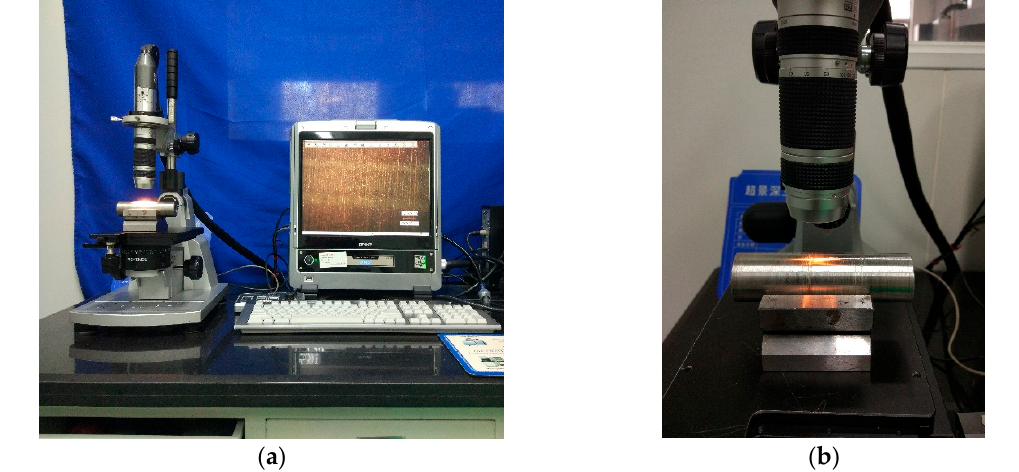
Figure 5. VHX-600E digital microscope: ( a ) Close up of the VHX-600E digital microscope; ( b ) The Figure 5. VHX ‐ 600E digital microscope: ( a ) Close up of the VHX ‐ 600E digital microscope; ( b ) The V ‐ V-shape shape support.